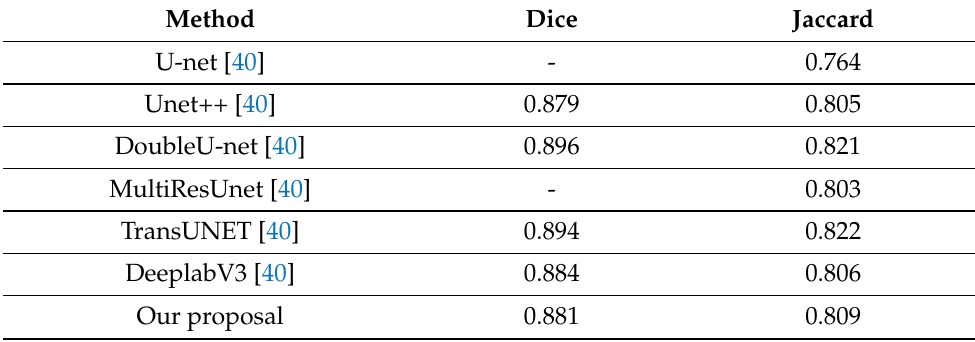
Table 2. Performance comparison with the previous studies on the ISIC 2018